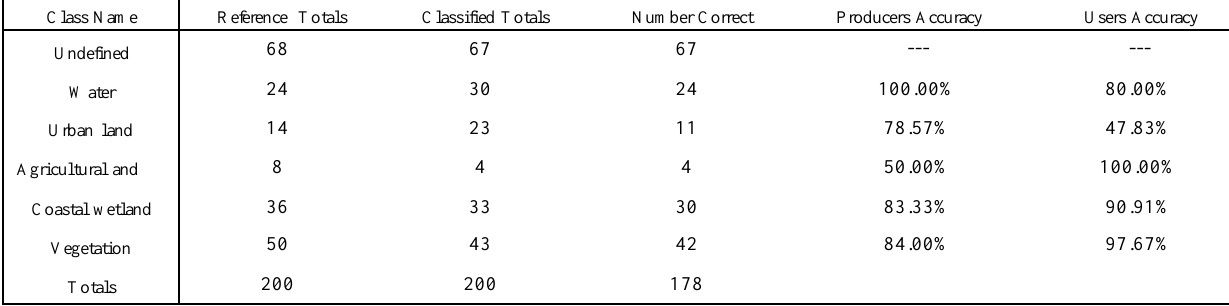
Table 7 . Accuracy Evaluation of TC